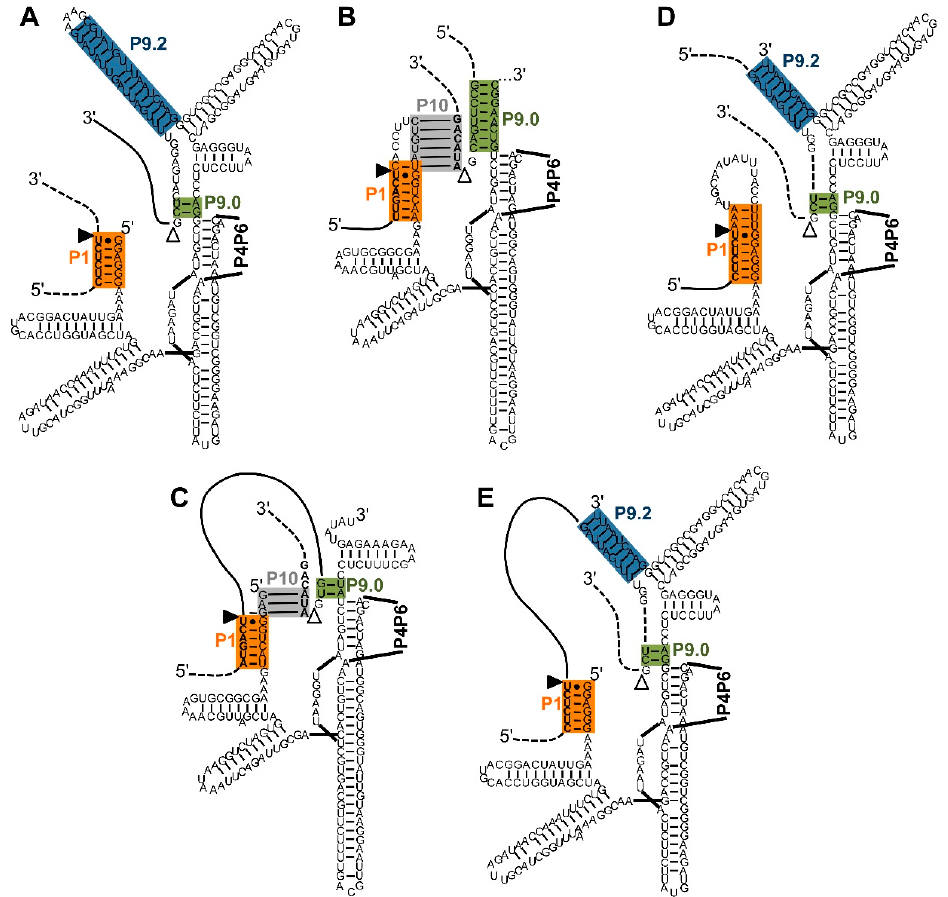
Figure 2. Five types of interactions between trans -splicing ribozymes and their substrates. Note that the P4–P6 domains are not shown for clarity. Color-coding and the (non-physical) overlap of helices P1 extension and P10 are as described in Figure 1. ( A ) Secondary structure of a Tetrahymena ribozyme variant designed for trans -splicing at the 5 ′ -splice site [5]. During two trans phosphorylation reactions, the 3 ′ -portion of the substrate (dashed line) is replaced by the 3 ′ -exon of the ribozyme construct (solid line); ( B ) Secondary structure of a Pneumocystis carinii ribozyme variant designed for trans -splicing at the 3 ′ -splice site [6]. The substrate is positioned to the 3 ′ -splice site by the P10 and P9.0 helices. During two transphosphorylation reactions, the 5 ′ -portion of the substrate (dashed line) is replaced by the 5 ′ -exon of the ribozyme (solid line). Note that the P9.0 helix is artificially elongated; ( C ) Secondary structure of a Pneumocystis carinii ribozyme variant designed for trans -splicing at the 5 ′ and 3 ′ -splice site [30]. The design uses the trans -contacts shown in ( A , B ). During the transphosphorylation reactions, the internal sequence (solid line) of the substrate is removed, joining the two flanking exons (dashed lines); ( D ) Secondary structure of a Tetrahymena ribozyme variant designed for trans -splicing at the 3 ′ -splice site [8]. The P9.2 and P9.0 helices position the substrate to the 3 ′ -splice site. During the transphosphorylation reactions the 5 ′ -portion of the substrate (dashed line) is replaced by the 5 ′ -exon of the ribozyme construct (solid line); ( E ) Secondary structure of a Tetrahymena ribozyme variant designed for trans -splicing at the 5 ′ and 3 ′ -splice site [8]. The design uses the trans -contacts shown in ( A , D ). During the transphosphorylation reactions, the internal sequence (solid line) of the substrate is removed, and the two flanking exons (dashed lines) are joined.